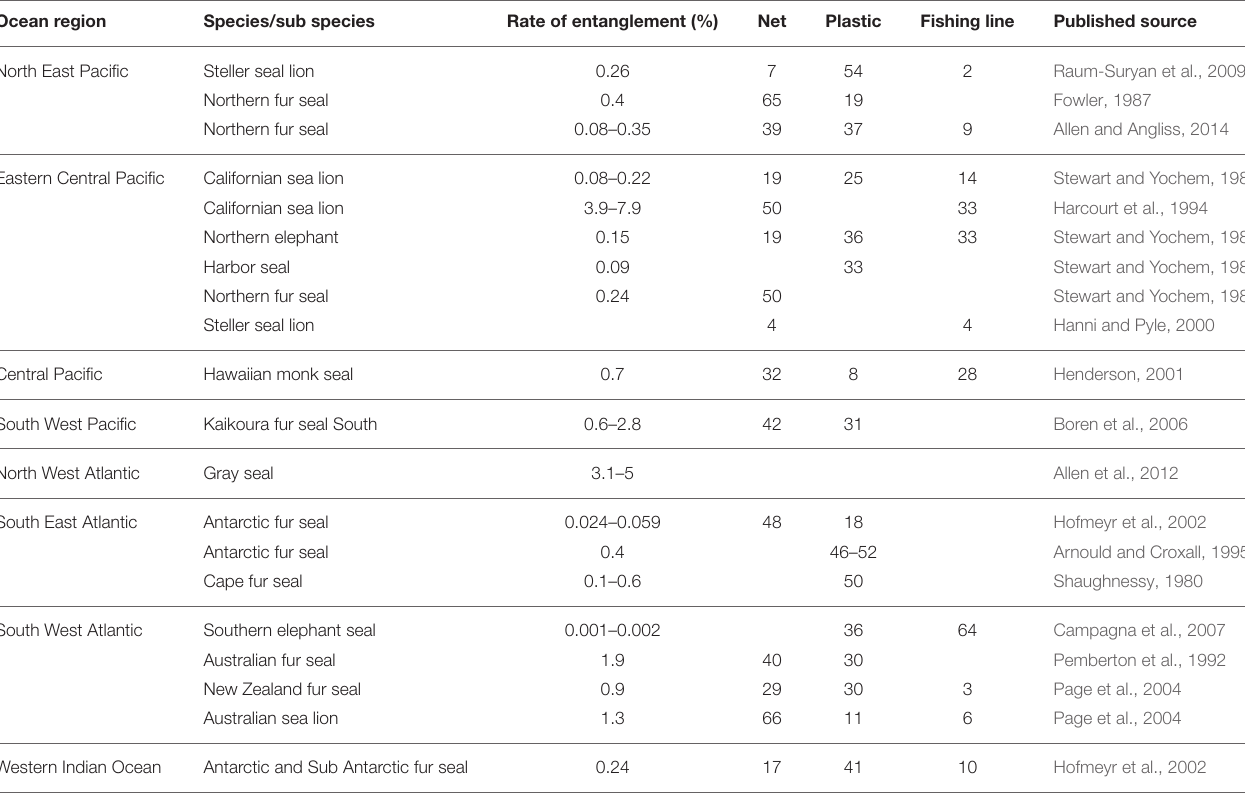
TABLE 1 | Summary tabulation of reported entanglement rates for the pinniped species found in different ocean regions—the rate of entanglement (estimated % of population annually), and the net, plastic, and fishing line (% of reported entanglement cases for each category respectively), and the published source of the